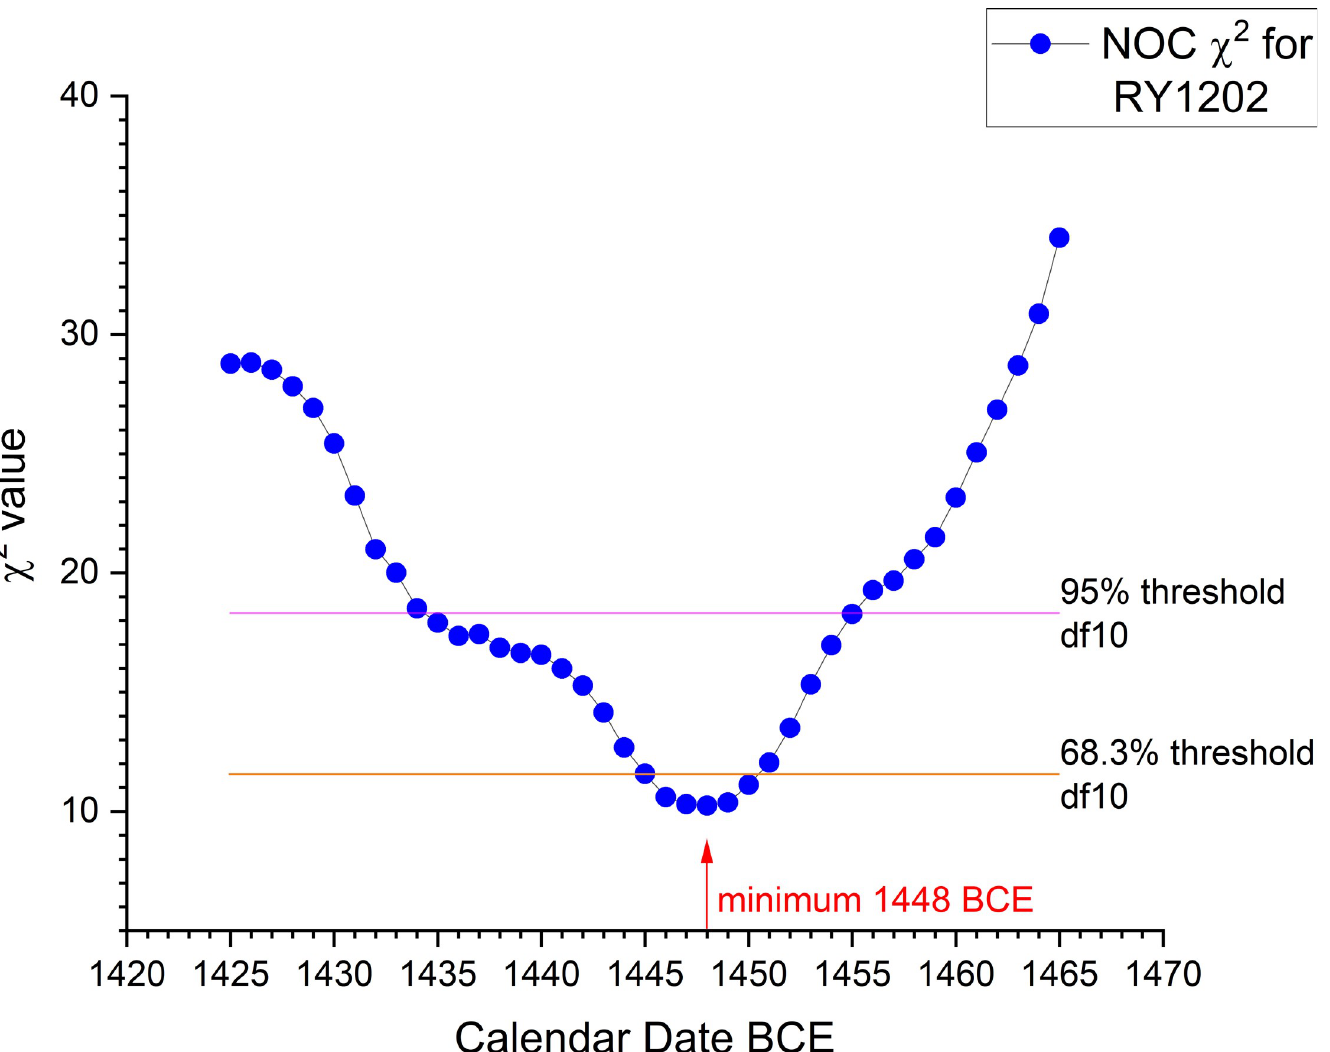
Fig 16. χ 2 fit function for the NOC wiggle-match against the IntCal20 14 C calibration curve [29] expressed in terms of the placement of RY1202 (the last 14 C dated element).